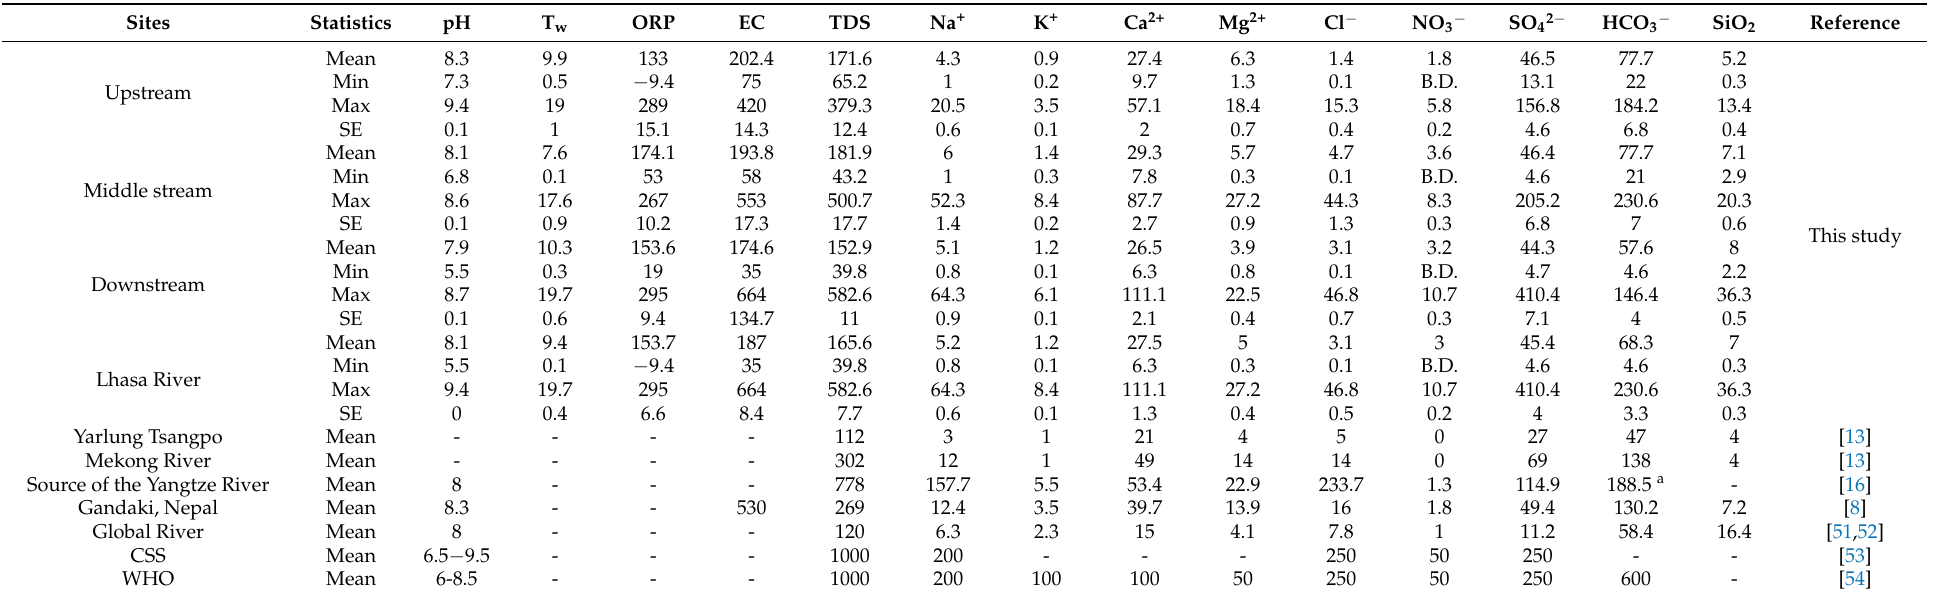
Table 1. Mean value, minimum value (Min), maximum value (Max), and standard error (SE) of water chemistry data of the different reaches of the LR. Values of water chemistry data in the World Health Organization (WHO) and Chinese State Standard (CSS) for drinking water are also shown.